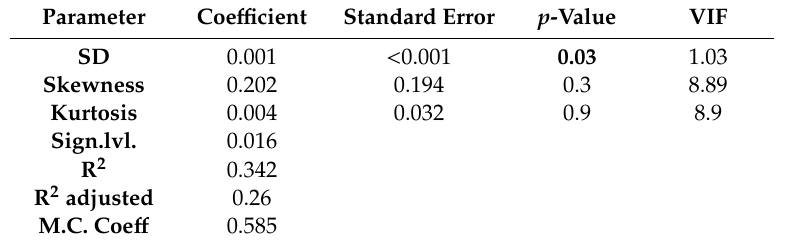
Table 5. Multivariateanalysisofparametersindependentlyassociatedwiththepresenceofmalignant cysts. Parameter Coe ffi